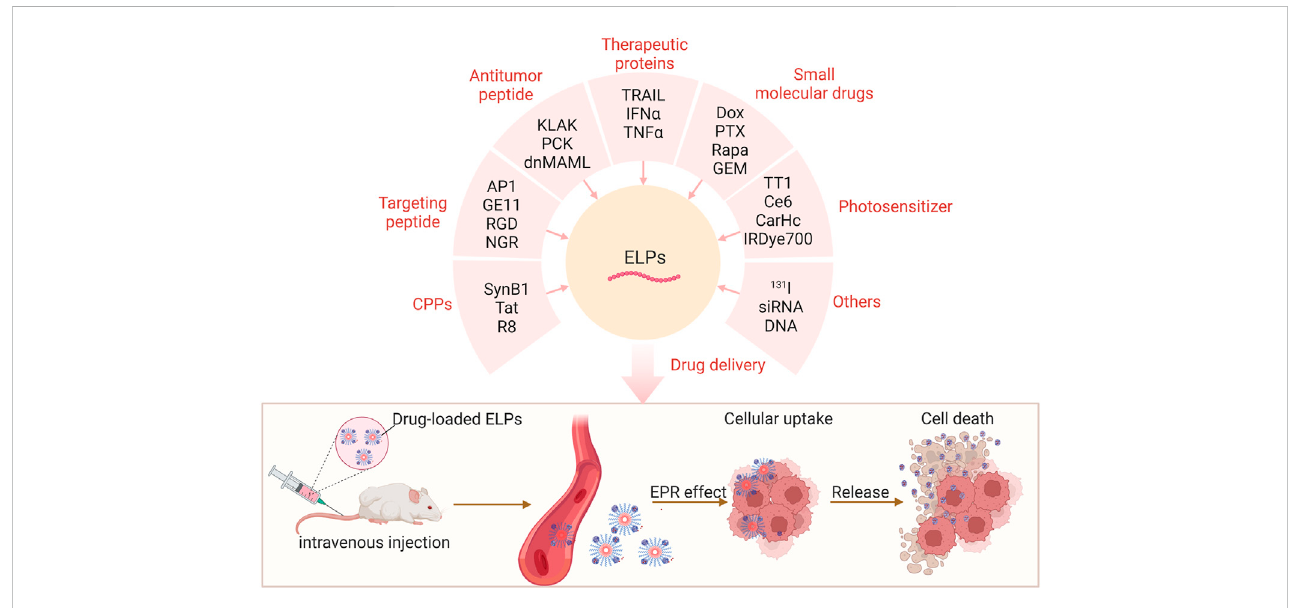
FIGURE 2 ELPs deliver functional peptides, therapeutic proteins, small molecule drugs, and photosensitizers for enhanced cancer